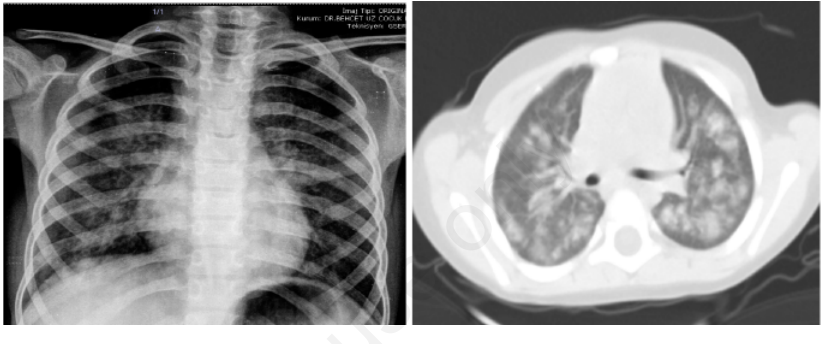
Figure 1. Chest imaging demonstrated reticulonodular infiltrates and thorax computed tomography showed ground-glass opacities, patchy infiltrates and